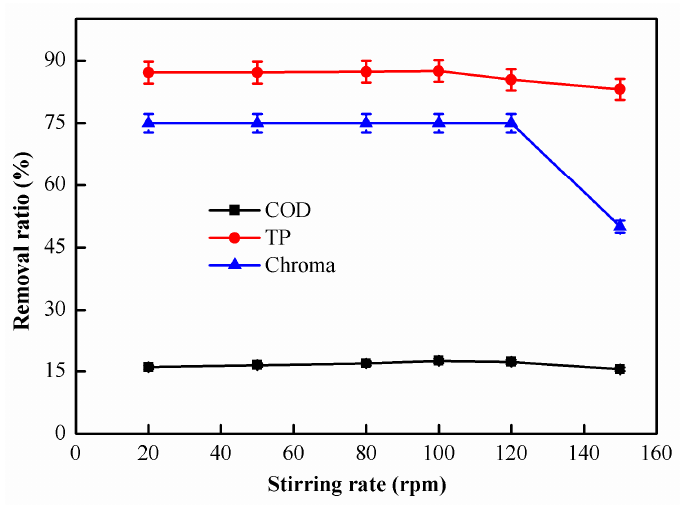
Figure 5. Effect of stirring speed on coagulation performance.